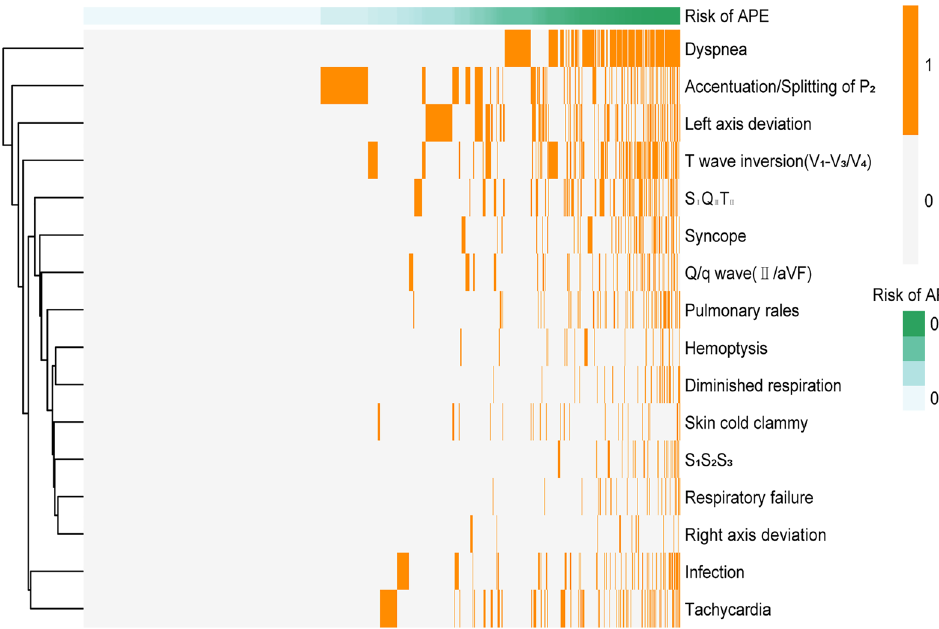
Figure 4. Heatmap to display the occurrence of the individual predictor variables for each sample. The figures were created using R software v4.0.2.